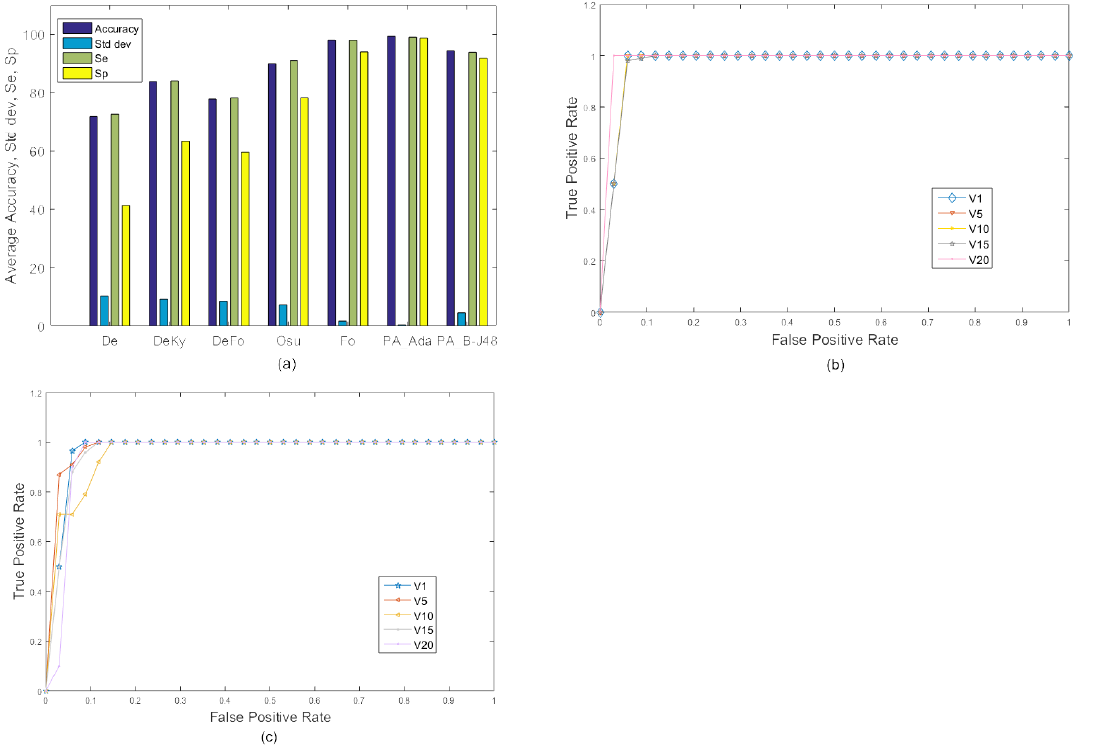
Figure 5. Experiment 2: Average comparison of the existing approaches and the proposed approaches on the MCF dataset with 10-fold cross validation using two categories: ‘Fall’ and ‘No Fall’. ( a ) Graph; ( b , c ) ROC curve of selected videos (videos 1, 6, 10, 15, and 20) using camera 2 for the proposed approaches, PA_B-J48 and